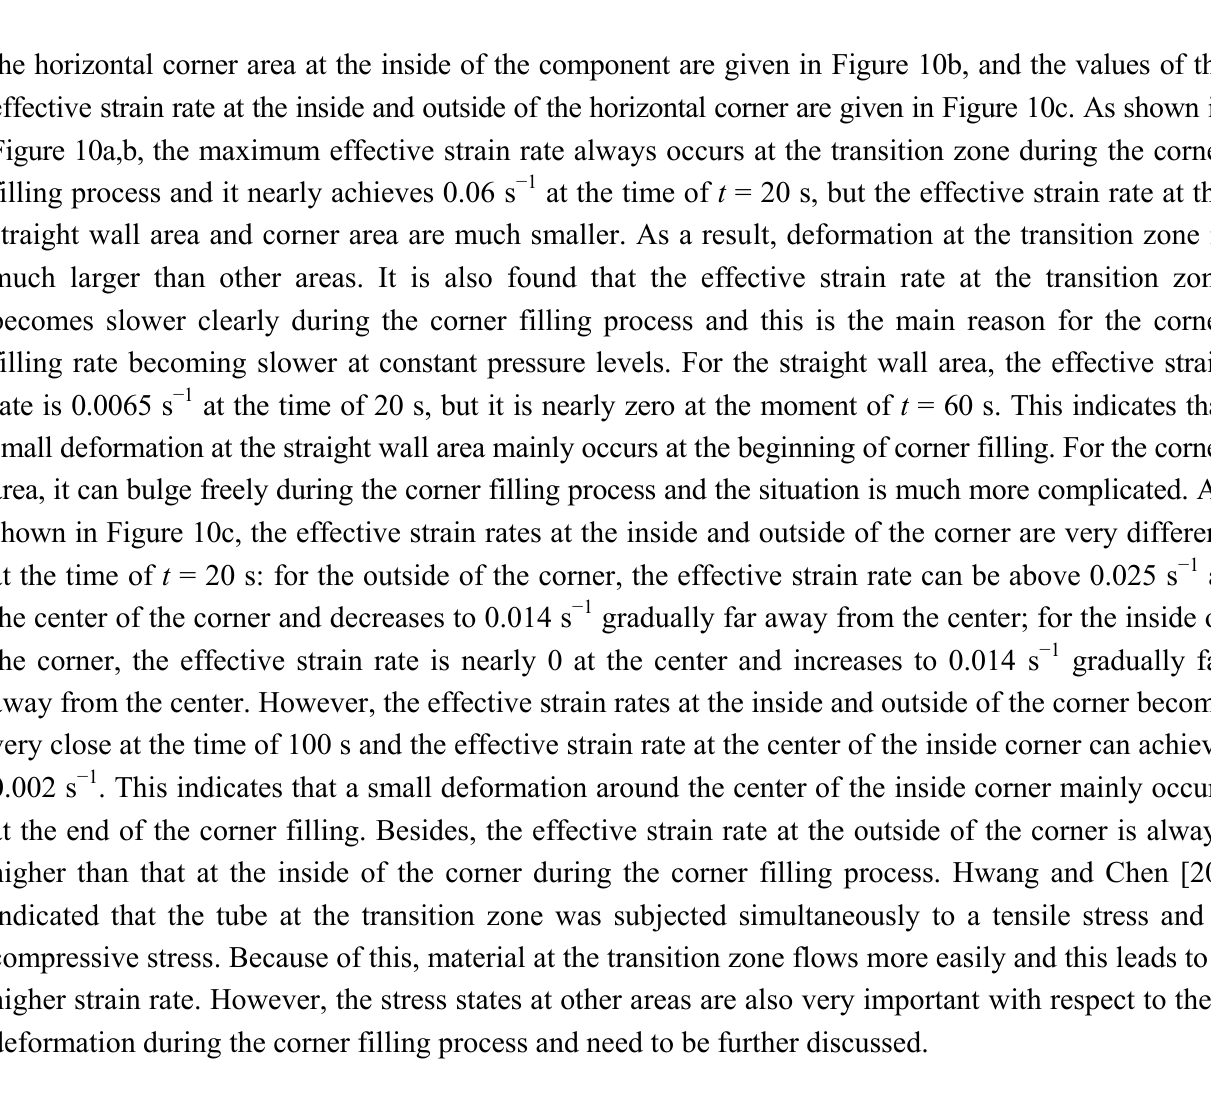
Figure 9. Effective strain distribution at the